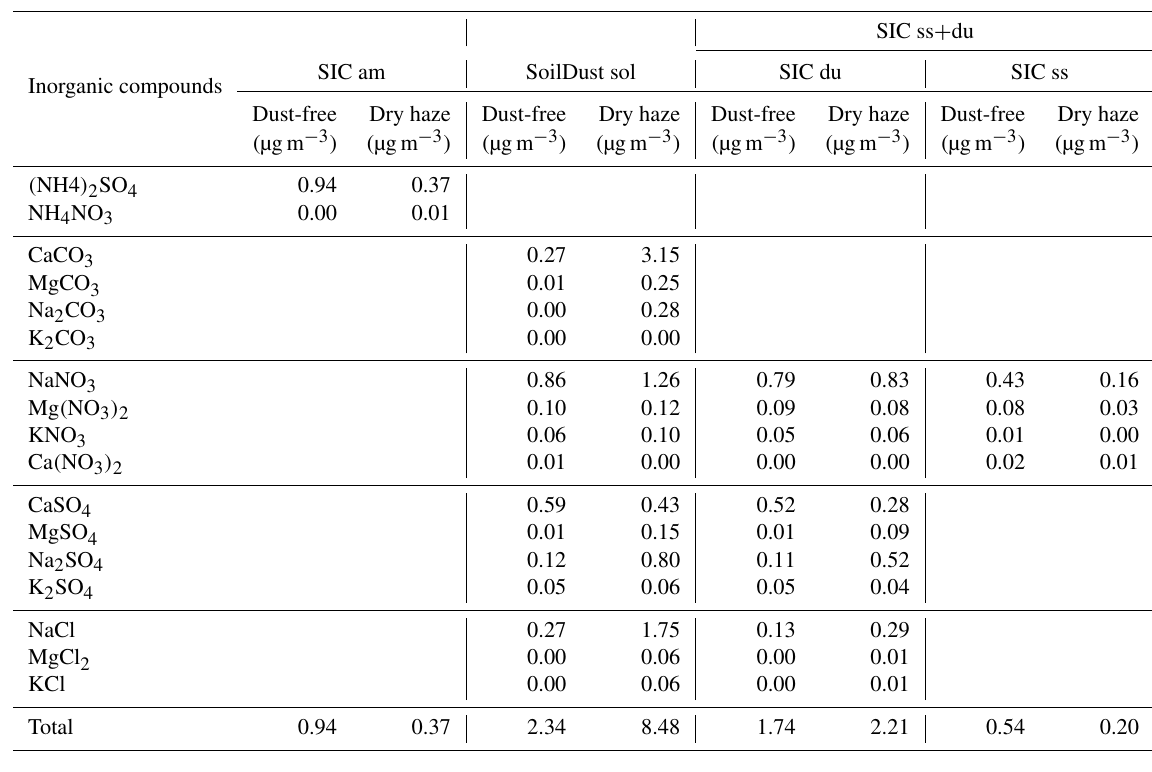
Inorganic compounds